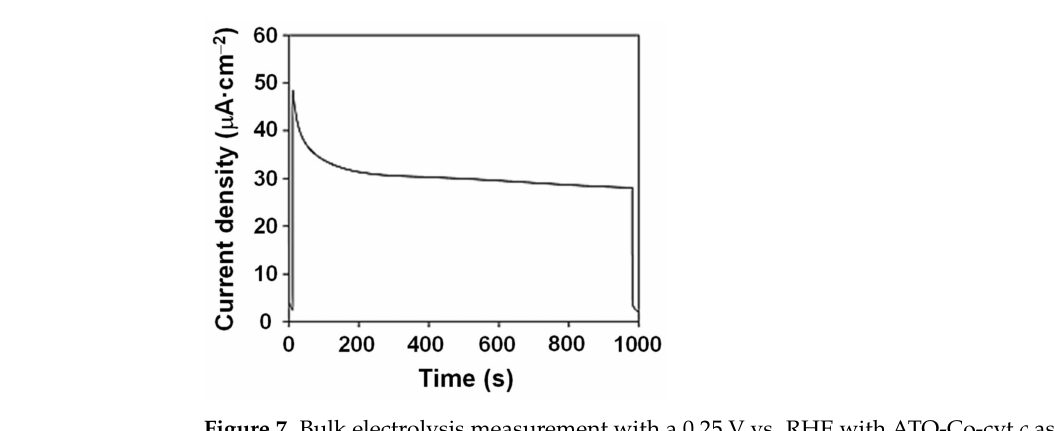
Figure 7. Bulk electrolysis measurement with a 0.25 V vs. RHE with ATO-Co-cyt c as the working electrode in 100 mM citrate buffer pH 5.0; illumination was performed with a blue light